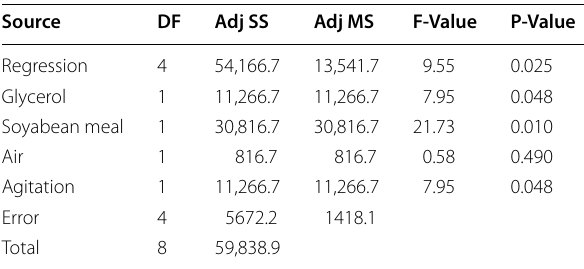
Table 8 Analysis of Variance for setomimycin production by Streptomyces sp.